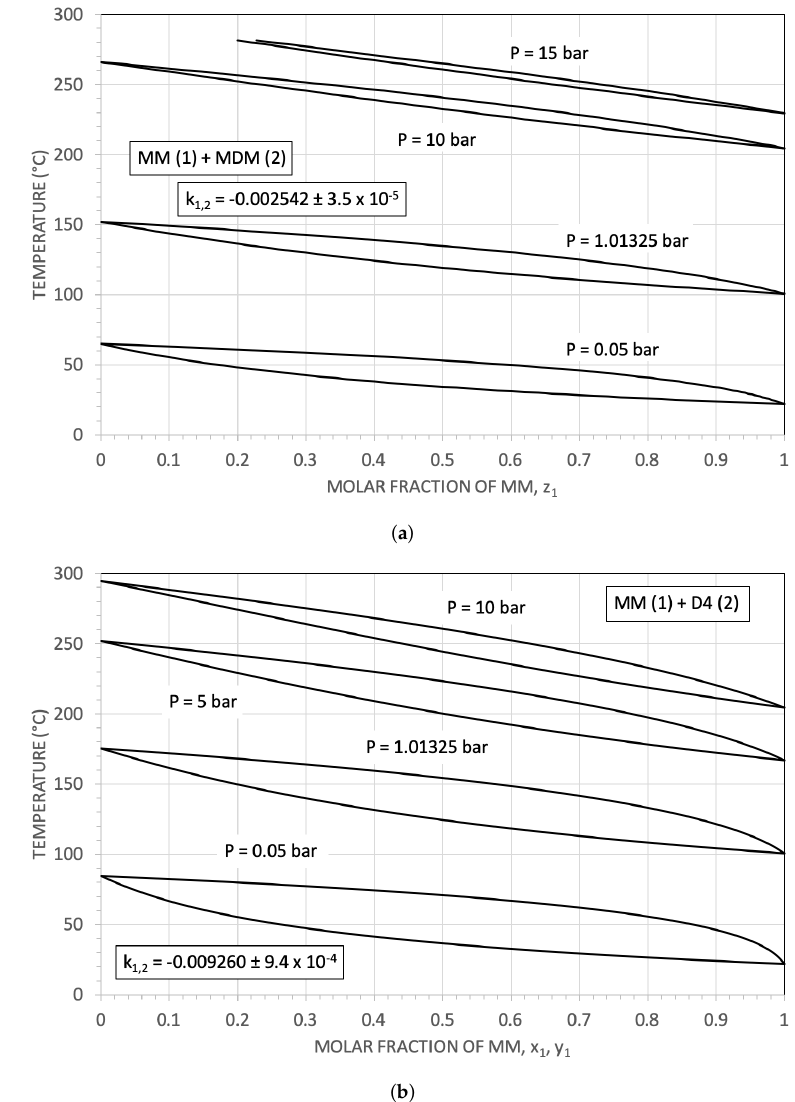
Figure 9. Vapour-liquid equilibrium lines for mixtures of siloxanes. ( a ) T-xy diagram for MM/MDM at different pressures. ( b ) T-xy diagram for MM/D 4